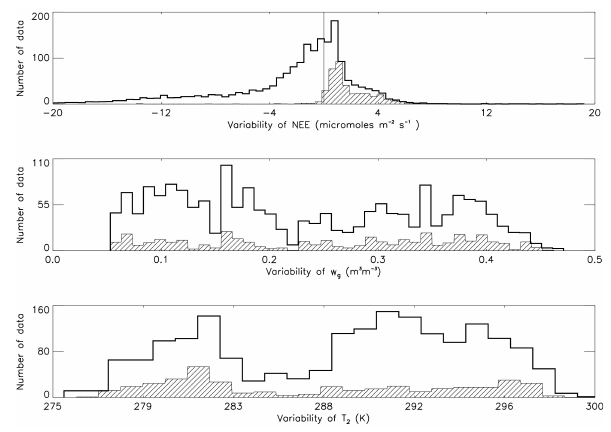
Fig. 1. Variability of the net CO 2 flux, w g and T 2 for wind di- rection between 225 and 315 degrees, sufficient turbulent exchange ( u ∗ > 0.16ms − 1 ), and in the absence of water deposition, for night- time data only (dashed area) and for pooled daytime and nighttime data (thick